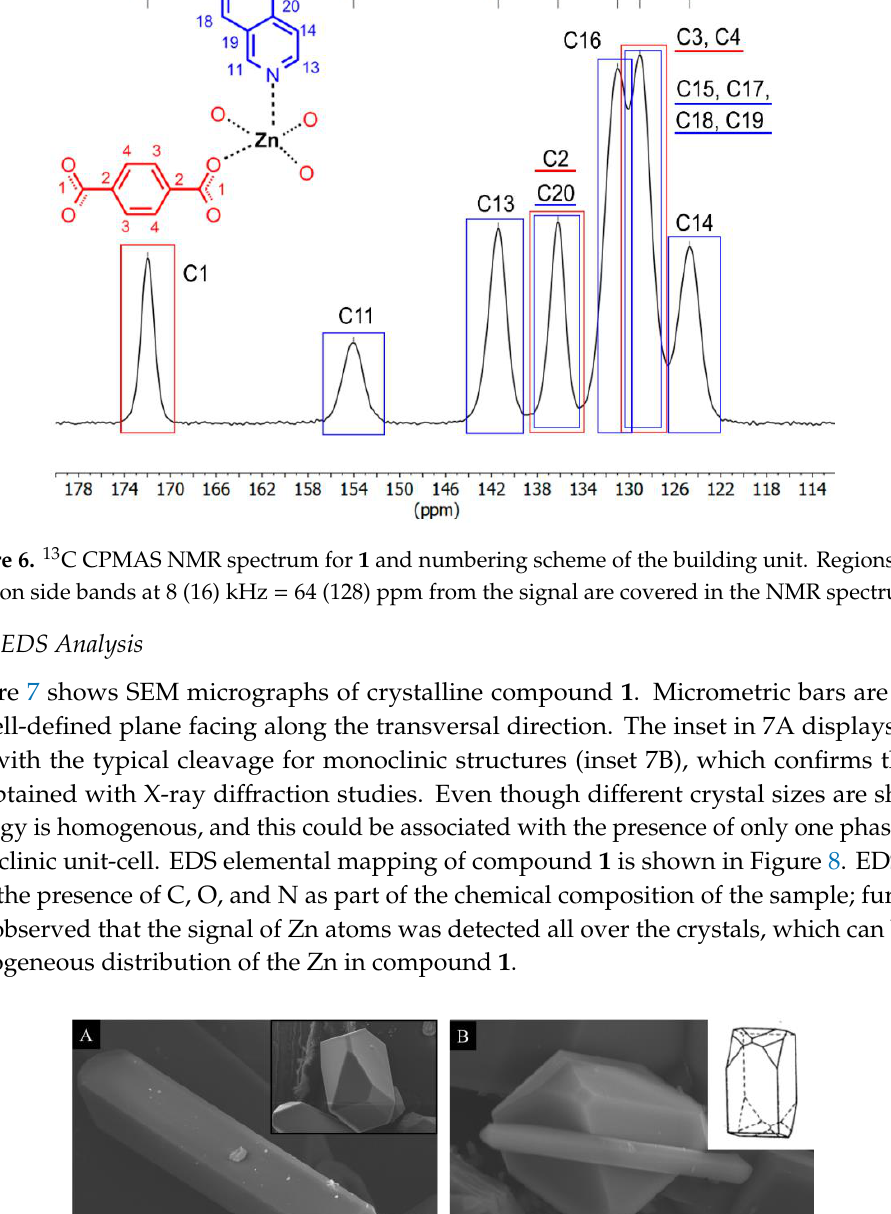
Figure 5. TGA and DTGA curves ( A ) and DSC ( B ) of 1 .